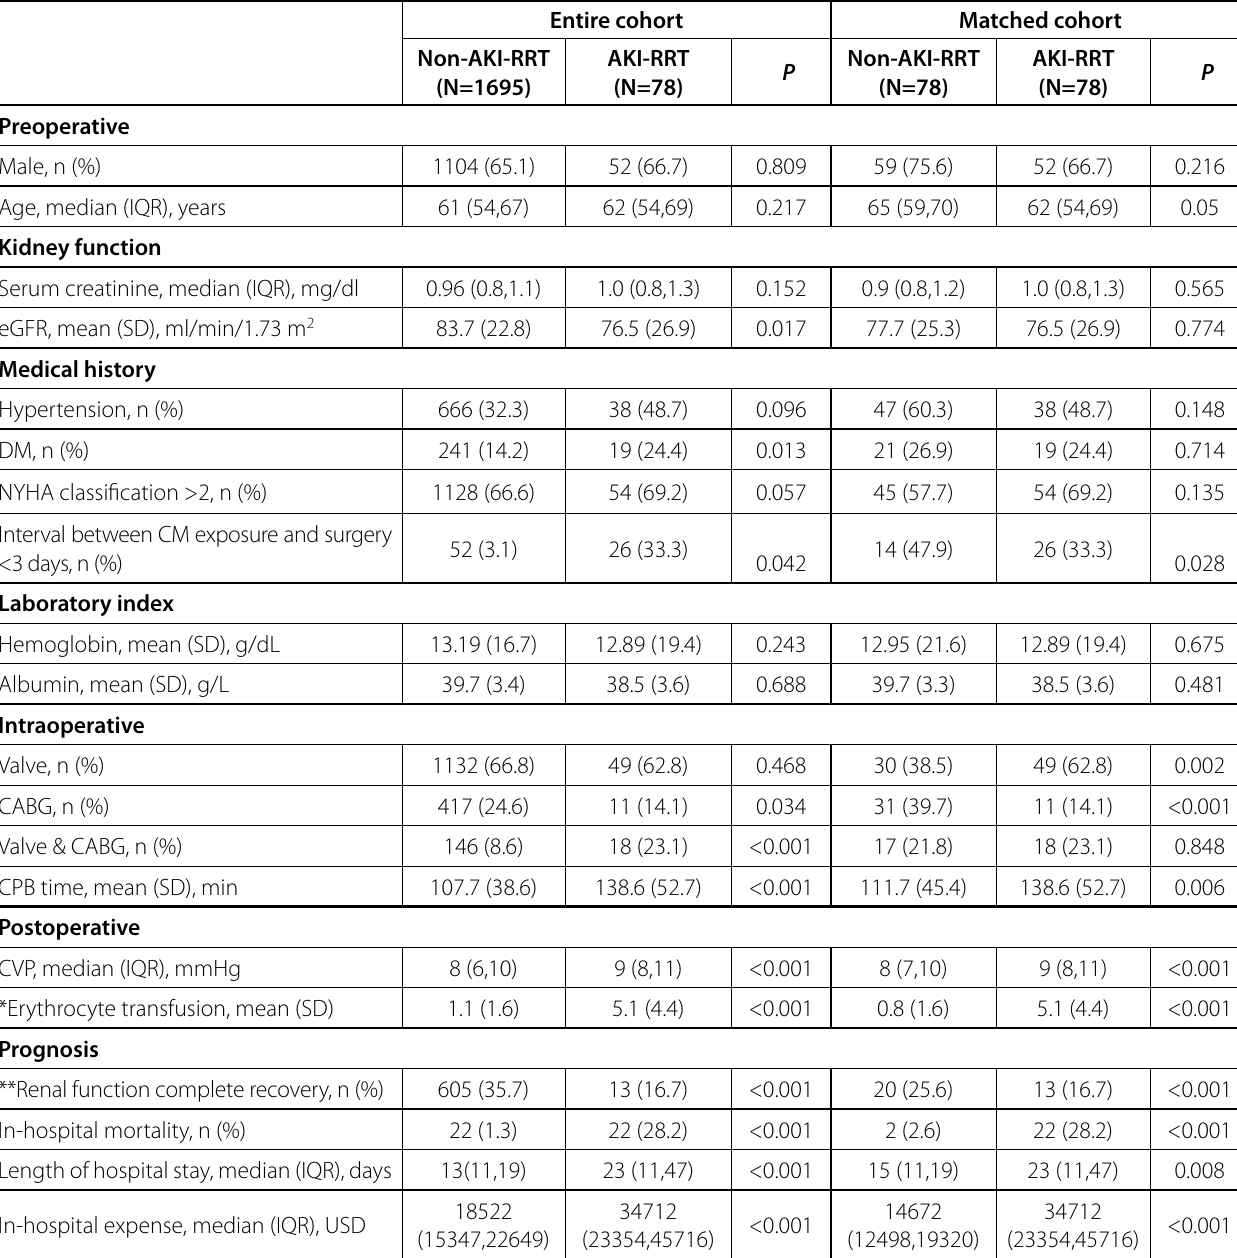
Table 1. Patients’ characteristics and perioperative parameters of the AKI-RRT and non-AKI-RRT groups in the entire and matched